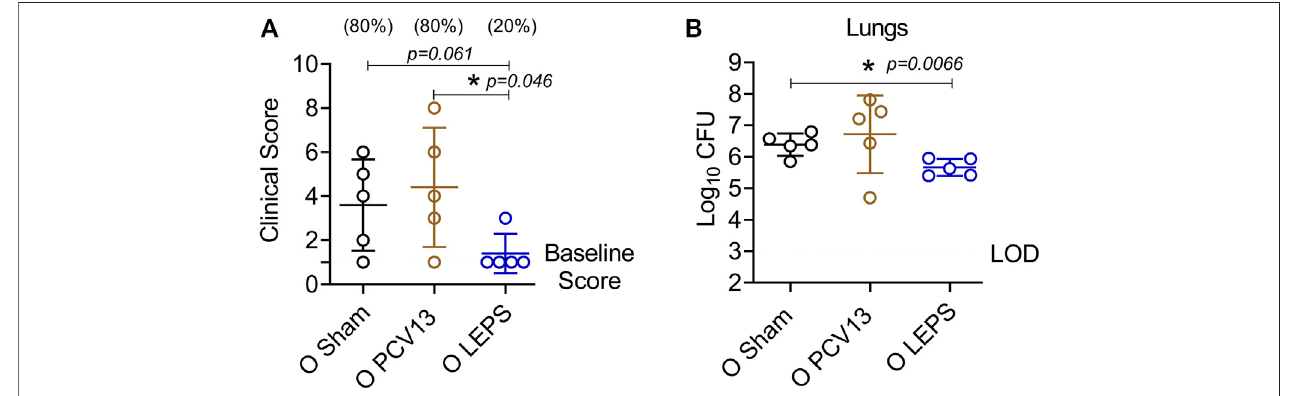
FIGURE 8 | LEPS vaccination protects old mice against pneumococcal pneumonia. Old (18 – 22 months) C57BL/6 mice were immunized with LEPS containing serotype 19F capsular polysaccharide antigen, PCV13, or the controls (Sham or Empty LEPS vector). Following the timeline presented in Figure 1B , 4 weeks after vaccination,micewereinfected i.t. with2 × 10 7 CFUof S.pneumoniae serotype19F.Clinicalscores (A) andbacterialburdeninthelungs (B) weredetermined24 hpost- infection. (A) Percentage of mice that displayed clinical signs of pneumonia are in parentheses. (A,B) Asterisks (*) indicate signi fi cant differences between the indicatedgroupsasdeterminedbyone-wayANOVAfollowedbyTukey ’ stest.Datashownarepooledfrom n (cid:2) 5micepergroupandpresentedasmean ± SD.Eachdot represents one mouse. LOD: limit of